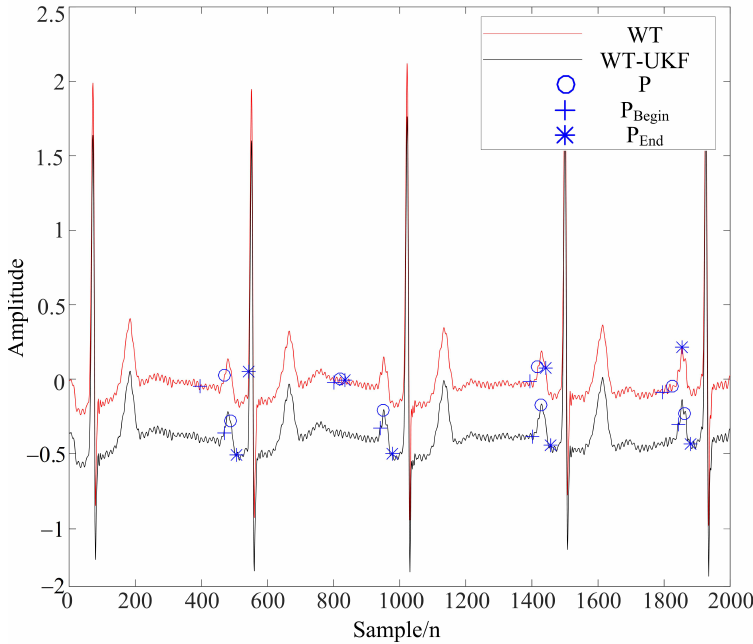
Figure 8. P-wave extraction results from ECG signals of subject 123 (MIT-BIH arrhythmia database).